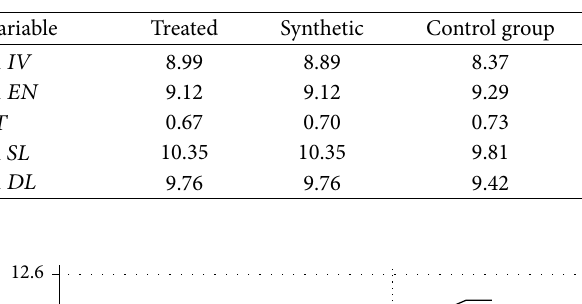
Table 5: Fitting and comparison of predictive variables.